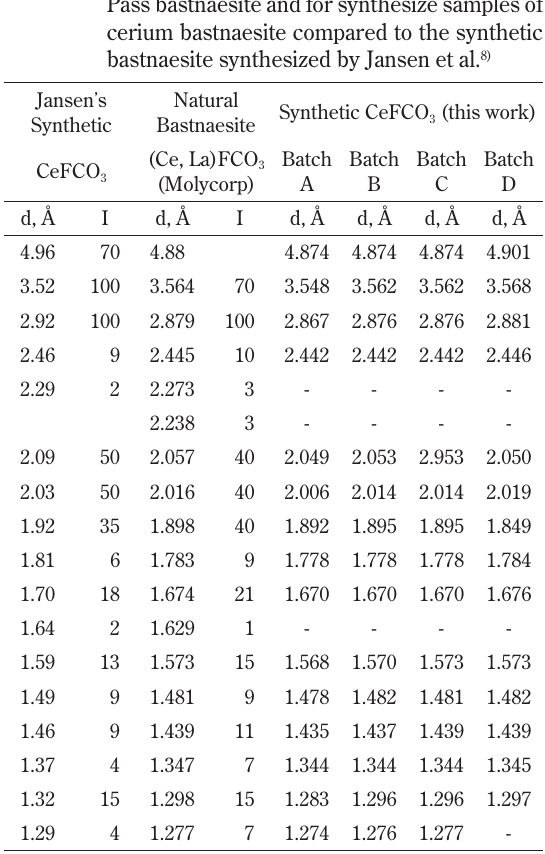
Table 2 X-ray diffraction pattern data for Mountain Pass bastnaesite and for synthesize samples of cerium bastnaesite compared to the synthetic bastnaesite synthesized by Jansen et al.